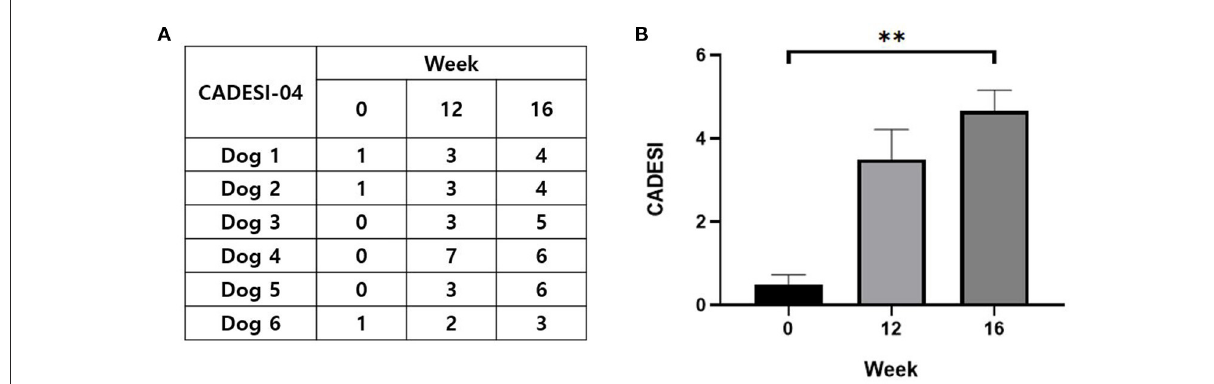
FIGURE5 Evaluation of the skin lesions. (A) CADESI-04 score of each subject at pre-sensitization, post-sensitization, and post-provocation. (B) Change in the CADESI-04 with the course of time. Zero week, pre-sensitization; 12 week, post-sensitization; 16 week, post-provocation. CADESI, canine atopic dermatitis extent and severity index. All values are expressed as the mean ± standard error. ** P < 0.01.